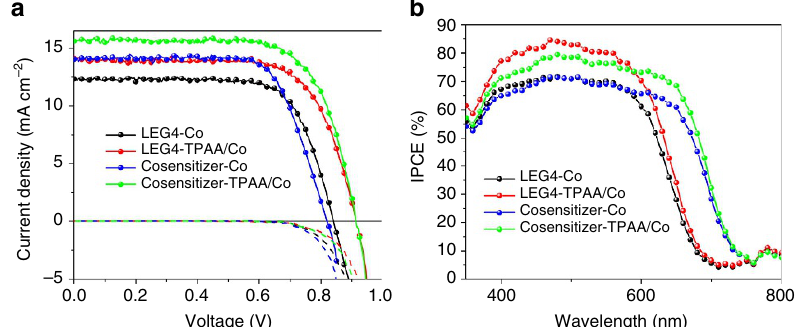
Figure 2 | JV curves and IPCE. ( a ) Current density versus applied potential curves under 100mWcm (cid:2) 2 AM 1.5G illumination (dot lines) and in darkness (dashed lines). ( b ) Spectra of incident photon-to-current conversion efficiency (IPCE) for DSSCs based on LEG4 dye and co-sensitized (D35/Dyenamo